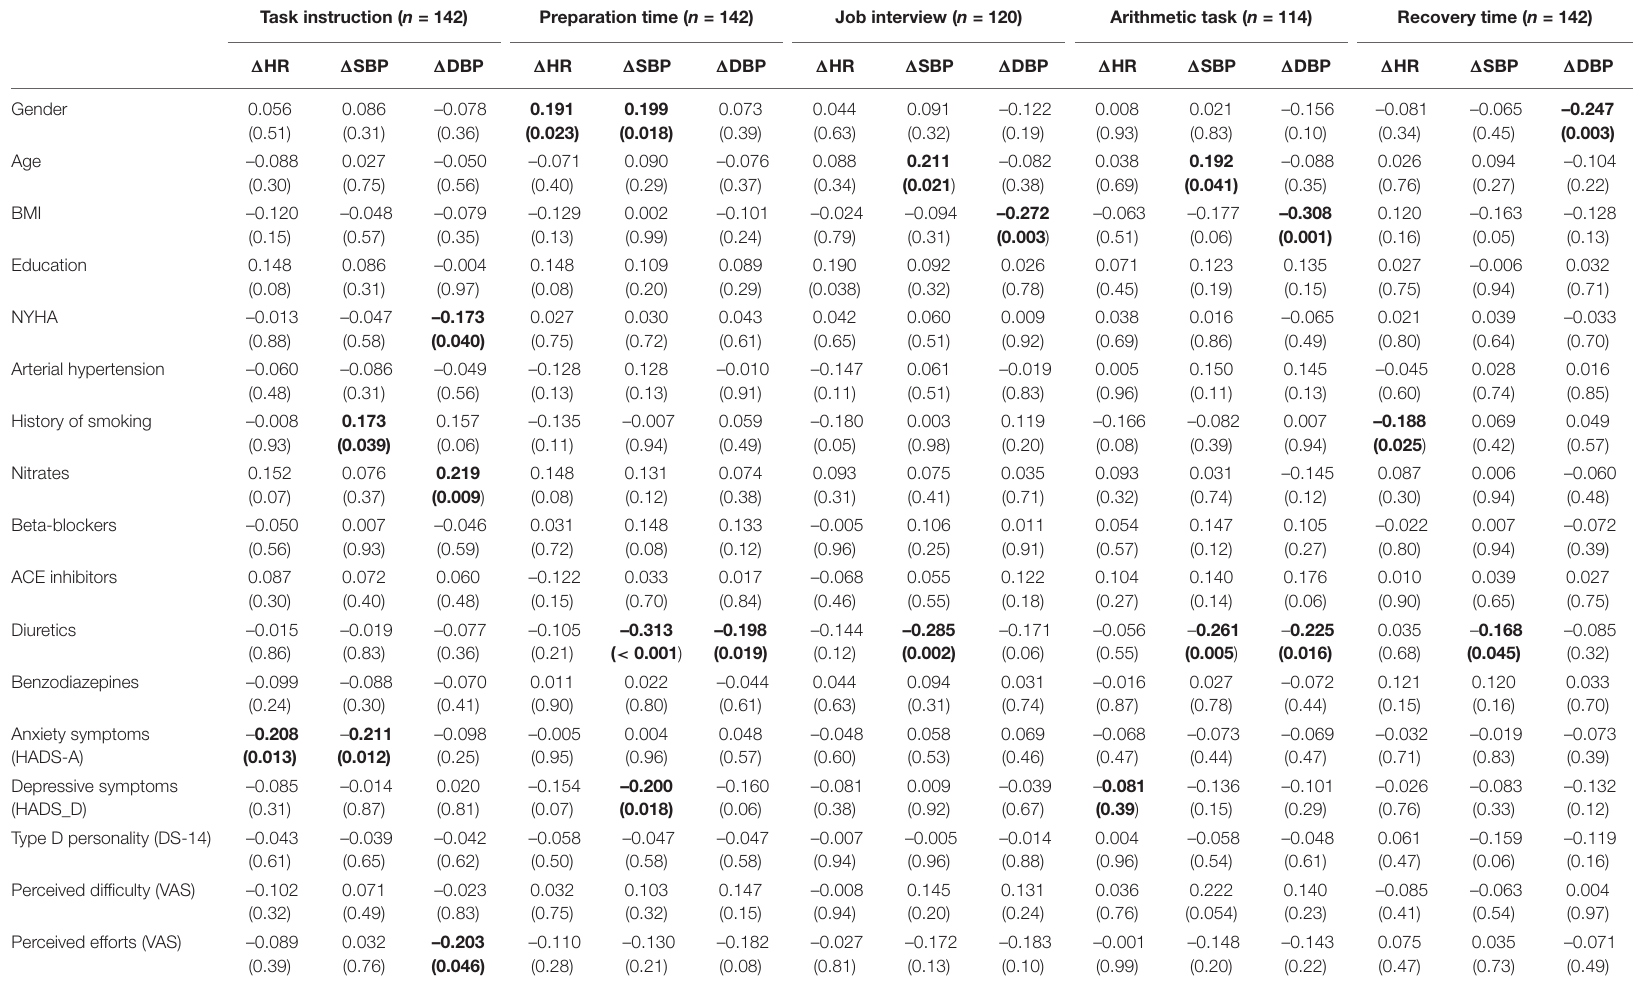
TABLE 4 | The associations between cardiovascular reactivity during Trier Social Stress Test in six stages and sociodemographic and clinical